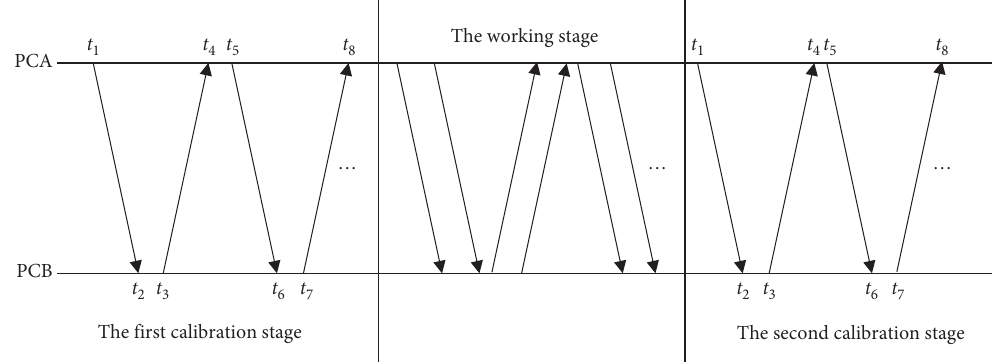
Figure 2: A three-stage delay correction